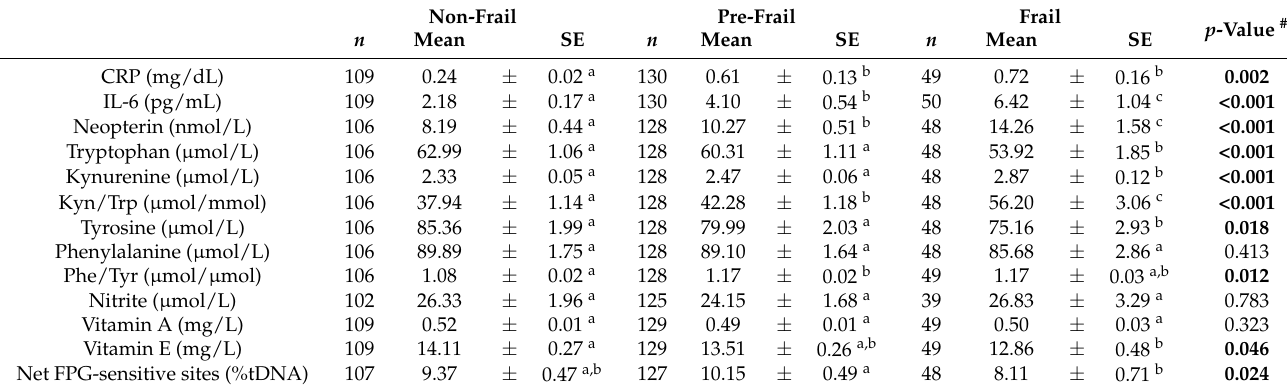
Table 2. Results of biomarkers in the study group, classified according to frailty status (univariate analysis).